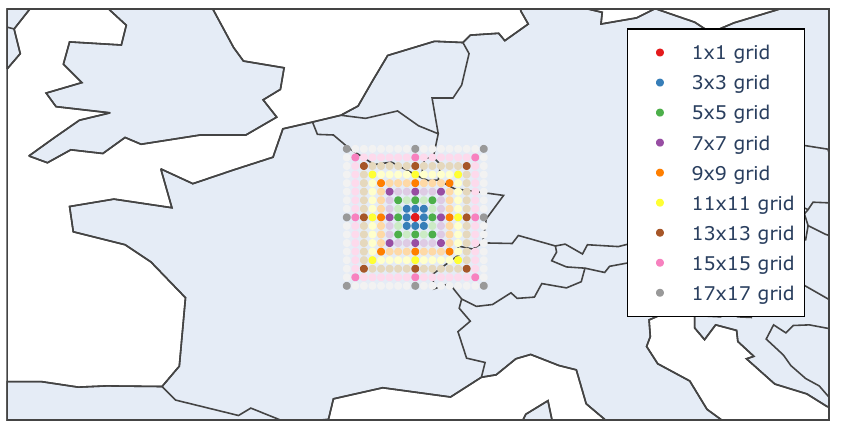
Figure 8. Perimeters of incrementally larger features maps (dark-colored and light-colored) and features associated with the main wind directions (dark-colored), one for each cardinal